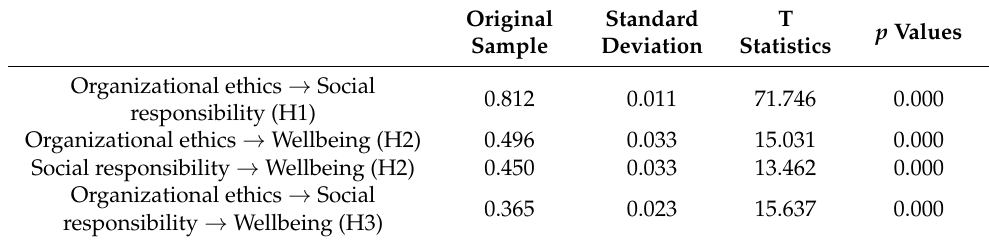
Table 4. Path coefficients and specific indirect